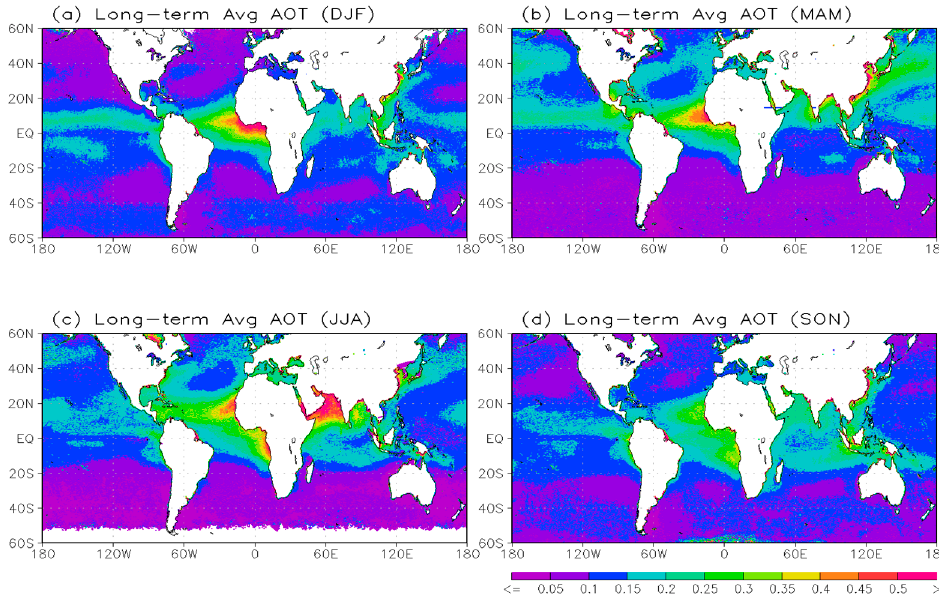
Figure 7. Global maps of the long-term averaged AOT for four seasons: ( a ) December, January, February (DJF); ( b ) March, April, May (MAM); ( c ) June, July, August (JJA); and ( d ) September, October, November (SON).